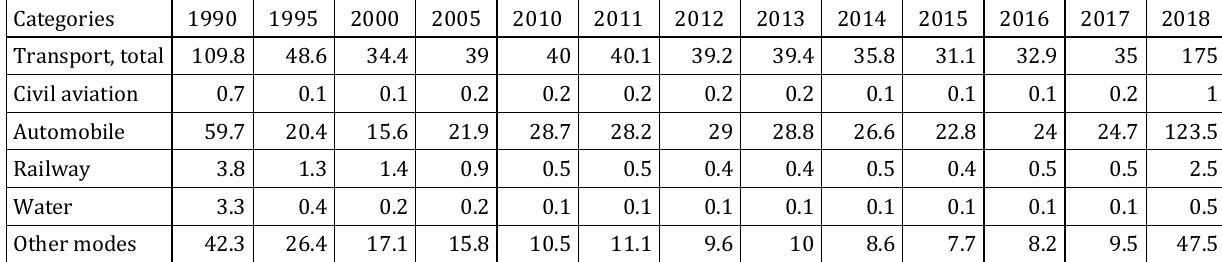
Table 2. CO 2 emissions from transport between 1990-2018 in Ukraine, millions of tons of CO 2 -eq.